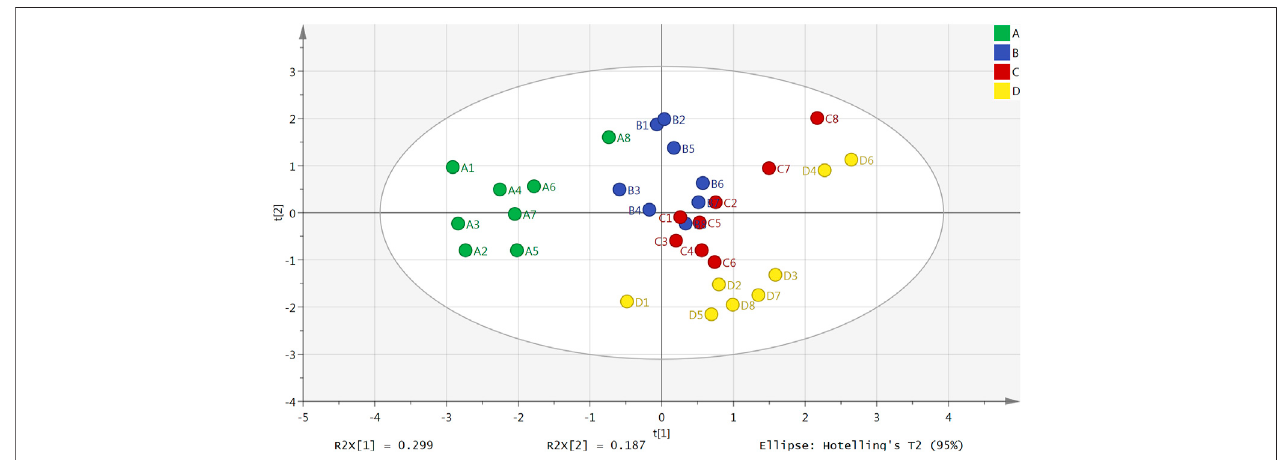
Frontiers in Pharmacology |